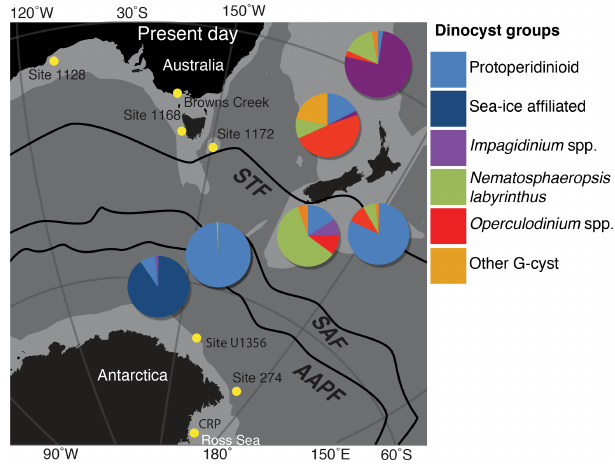
Figure 3. The present-day distribution of dinoflagellate cyst assem- blages in the southwest Pacific sector of the Southern Ocean, de- rived from surface sample data generated by Prebble et al. (2013) and displayed in Sangiorgi et al. (2018). The black lines illus- trate the location of oceanic fronts (Orsi et al., 1995), and yel- low dots mark the present-day locations of the drill sites studied (ODP Site 1168) and discussed in this paper (IODP Site U1356, ODP Site 1172 and 1128, DSDP Site 269 and 274, Cape Roberts Project – CRP, and Browns Creek). STF is the subtropical front, SAF is the subantarctic front and AAPF is the Antarctic polar front. Land masses are indicated in black, and the continental lithosphere is shown in light grey in the location map generated by GPlates freeware (http://www.gplates.org, last access: 13 June 2016), based on the global plates geodynamic motion model from Müller et al.